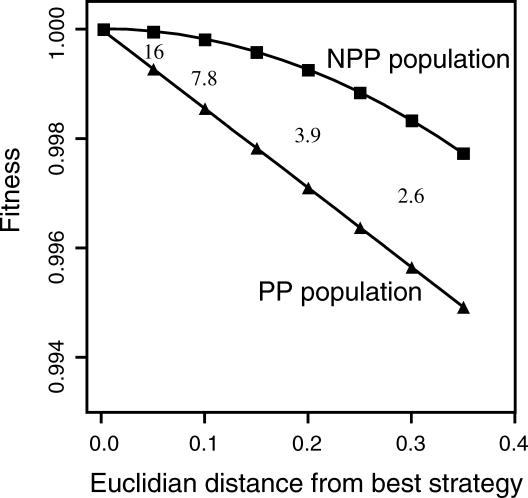
Effect on Fitness of Deviation from Optimal Foraging StrategiesCurves show the average fitness of populations that deviate by a fixed Euclidean distance (averaged over a quarter circle for PP-consumers and two points for NPP consumers, see text) from the optimal strategy (i.e., optimal eat probability values), which are at the fitness peaks in Figure 2A (PP-consumers) and Figure 2B (NPP-consumers). Deviations in trait values from the optimum have a markedly larger negative effect on fitness for PP-consumers. Numbers indicate the proportional decrease in fitness for PP-consumers relative to NPP-consumers at different deviations in trait values from the optimal strategy. For example, PP-populations with trait values deviating from the optimum eat probability by 0.1 suffer a fitness reduction 7.8 times greater than NPP-populations with equivalent deviation from the optimum.